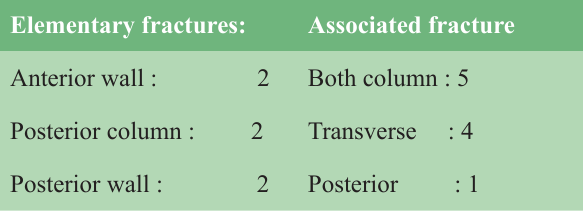
Table 2 :Fracture pattern: Leturonal and Judet